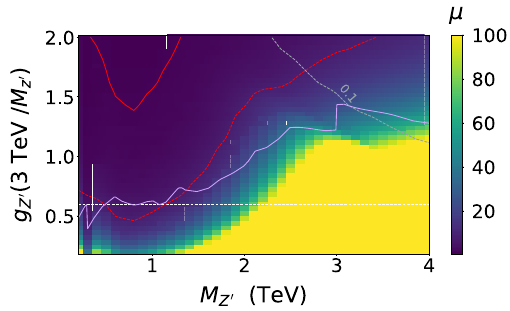
Fig. 8 μ for the b -tag category of the ATLAS di-muon search [63] at each point in the scanned parameter space. The solid red line shows the contour μ = 1. The area above this is excluded at the 95% CL. The dashed red line shows our estimate of the HL-LHC sensitivity. The solid purple line shows the current observed bound from all searches considered in this work. The region between the dashed white line and the bottom of the plot is favoured by the flavour and electroweak data at the 95% CL. Toward the extreme left-hand side of the plot, our pre- dictions become more inaccurate due to unaccounted-for O ( M 2 relative corrections